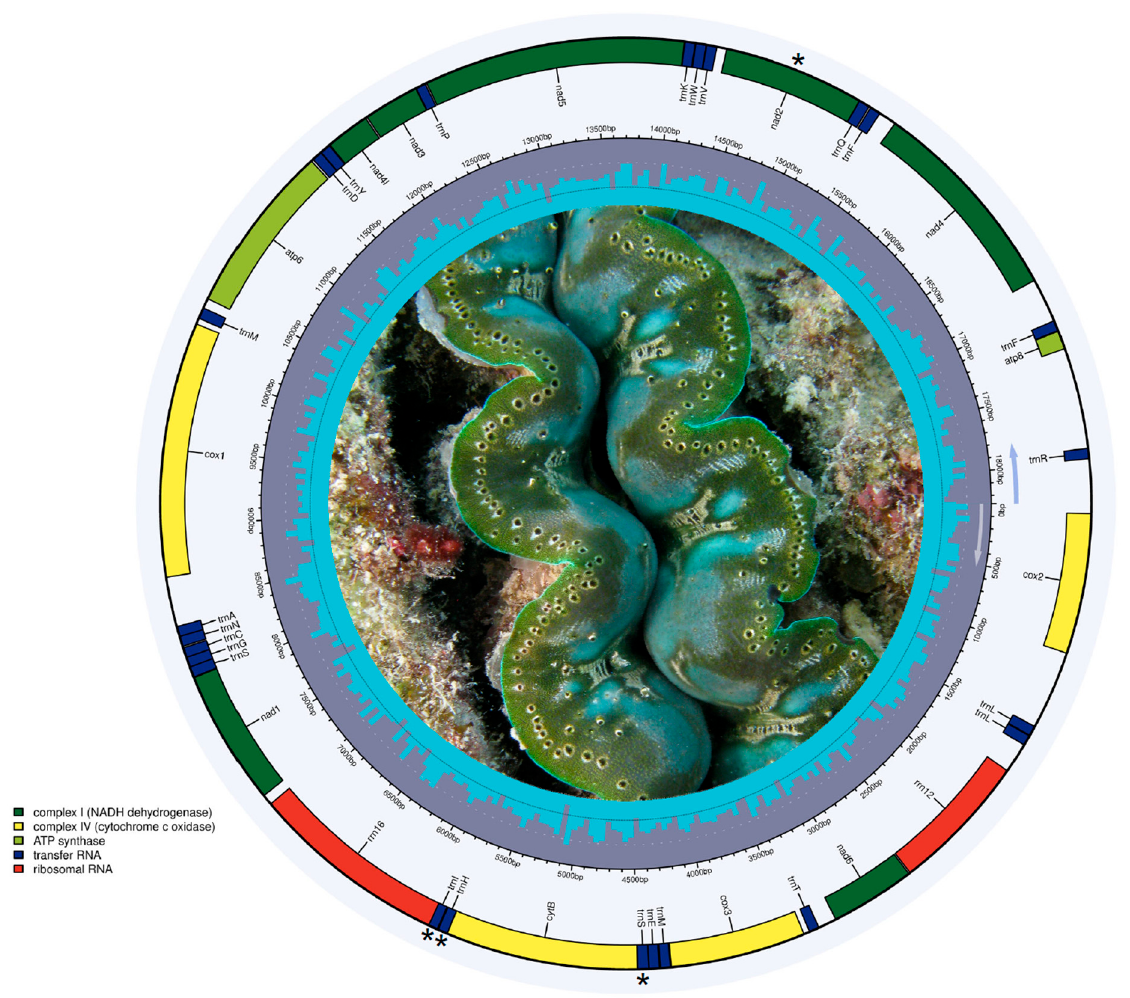
Figure 4. Circular genome depiction of the mitochondrial genome in Tridacna crocea based on RNA- seq data from [22]. Asterisks indicate transfer RNA genes retrieved and protein-coding genes not retrieved from RNA-seq data (photo credit: J. Antonio Baeza).